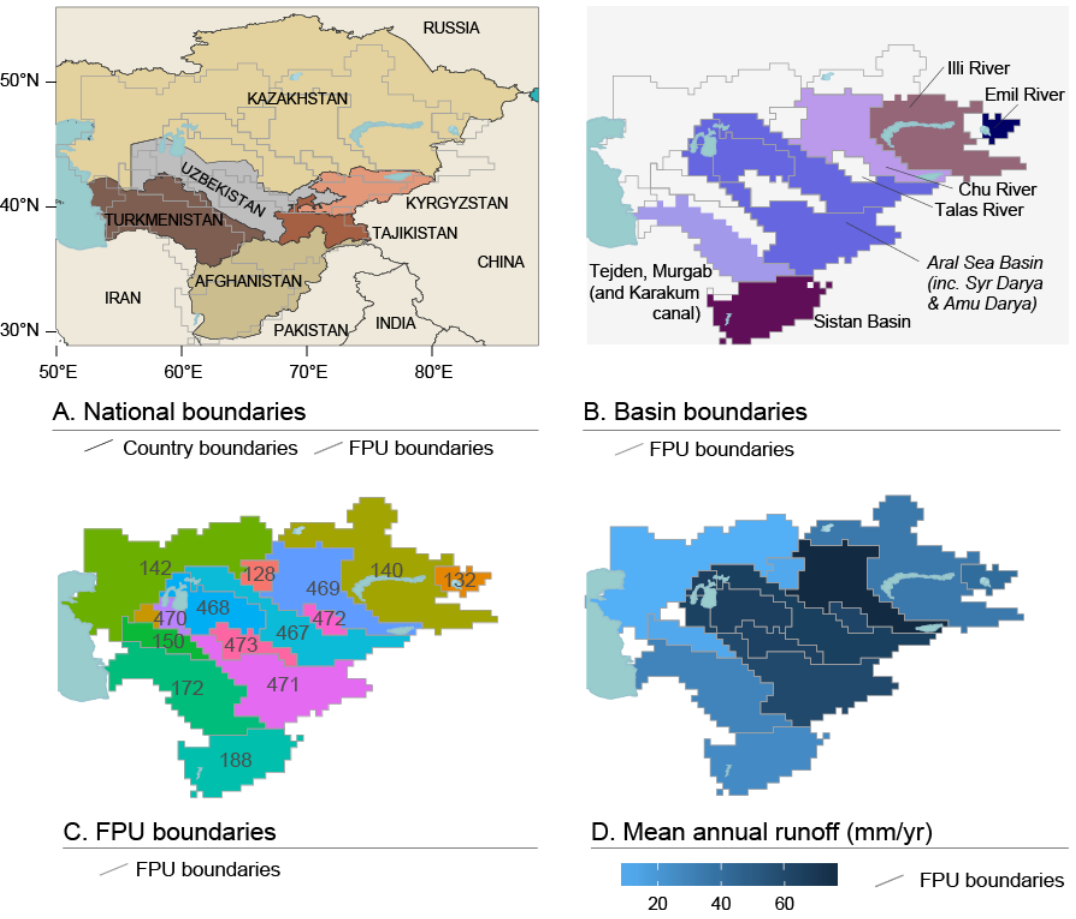
Figure 1. Map of study area: ( A ) national boundaries; ( B ) basin boundaries; ( C ) FPU boundaries; ( D ) mean decadal water availability for each food production unit (FPU); overlain with a selection of lakes